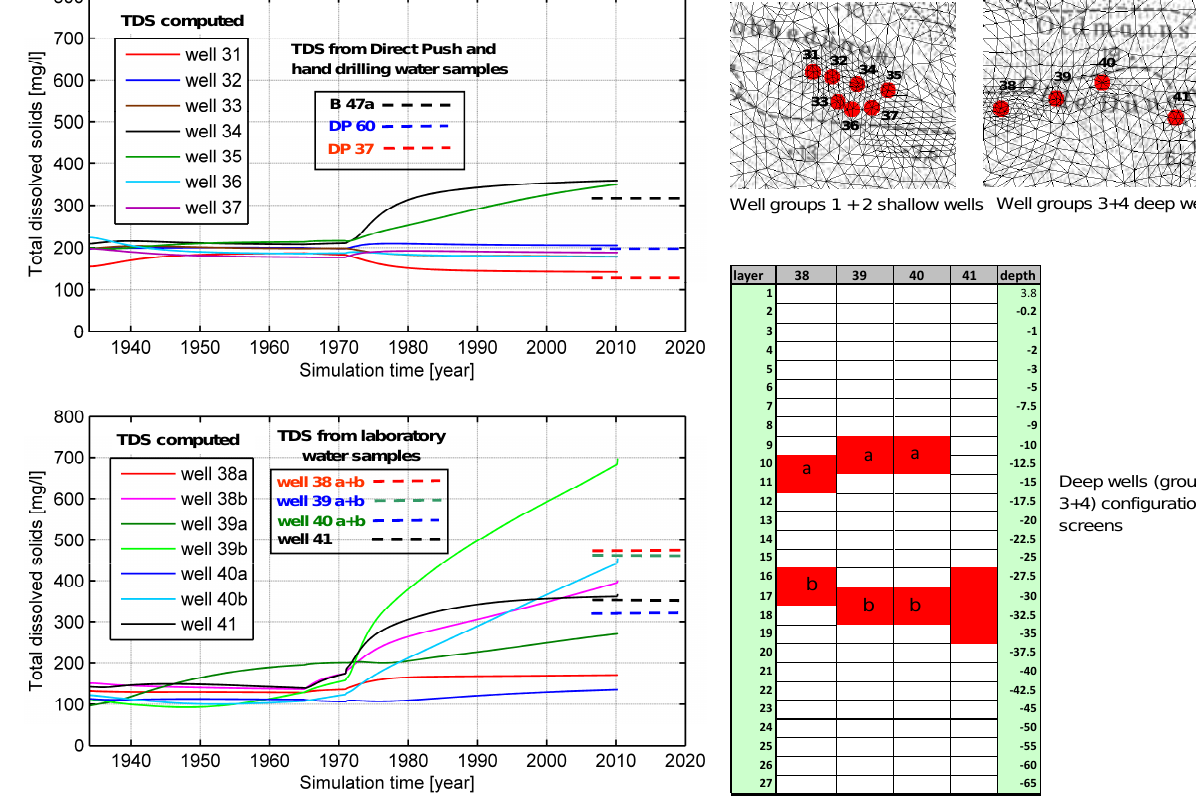
Fig. 14. Comparison of measured and computed TDS concentrations of WW II Ostland, top left panel: well groups 1+2, bottom left panel: well groups 3+4, top right panel: location of the well fields, (right) configuration of the well screens for well groups 3+4. (Depths are given in